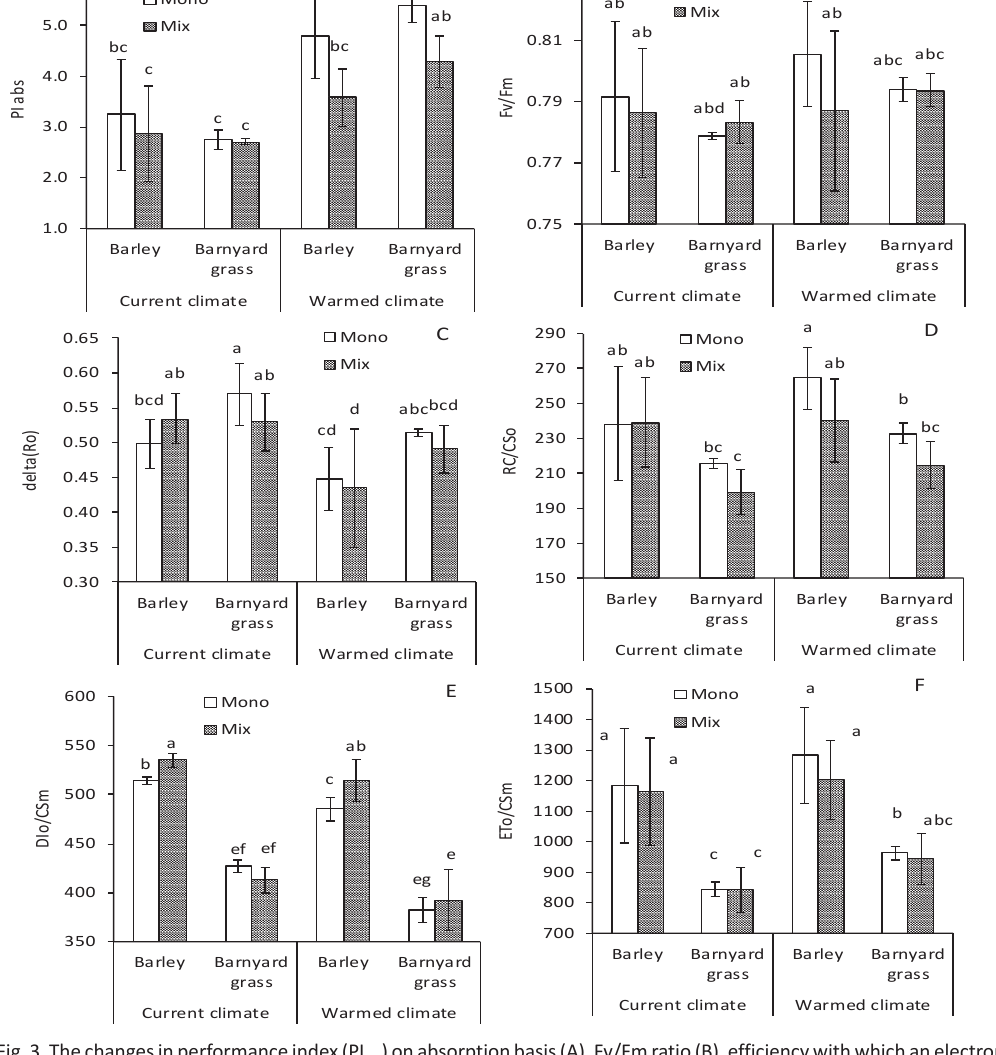
Fig. 3. The changes in performance index (PI ) on absorption basis (A), Fv/Fm ratio (B), efficiency with which an electron abs can move from the reduced intersystem electron acceptors to the PSI end electron acceptors (delta(Ro)) (C), density of RCs (QA-reducing PSII reaction centers) RC/CSo (D), dissipated energy flux per CS (DIo/CSm) (E), electron transport flux (ETo/CSm) (F) in barley ( Hordeum vulgare L.) and barnyard grass ( Echinochloa crus-galli L.) plant leaves grown in monoculture (Mono; 15 plants per pot) and mix culture (Mix; 9 crop plants and 6 weeds) at current (400 µmol mol -1 CO ; day/night temperatures 21/14 °C) and a warmed (800 µmol mol -1 CO ; day/night temperatures 25/18 °C) climate 2 2 conditions. Each value represents the mean ±CI (n=3). Different letters indicate significant differences at p <0.05 between the treatments as determined by Least Significant Differences (LSD)